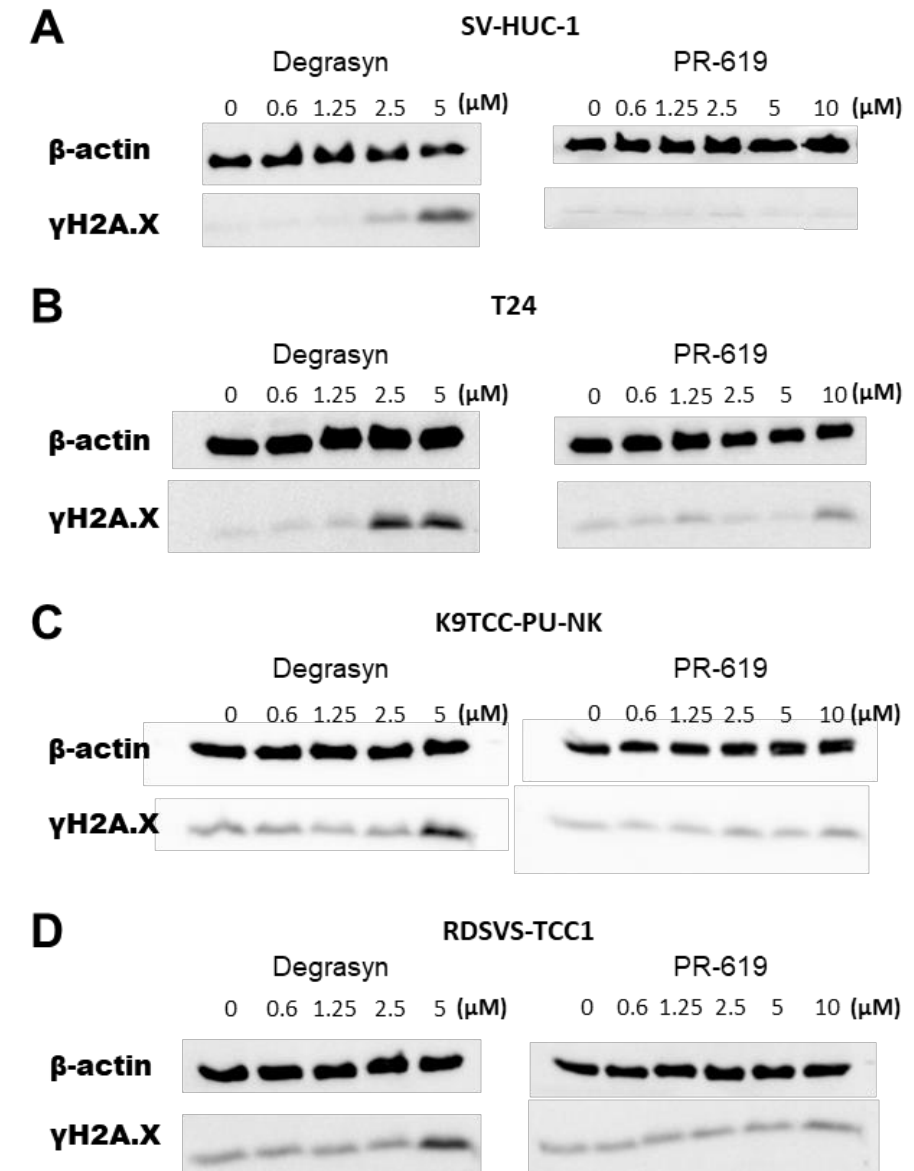
Figure 10. Evaluation of DNA damage generated by Degrasyn and PR-619. Representative blot of γH2A.X expression in ( A ) SV-HUC-1, ( B ) T24, ( C ) K9TCC-PU-NK, and ( D ) RDSVS-TCC cells after 24 h of treatment with increasing concentrations of Degrayn and PR-619. Actin serves as a loading control.